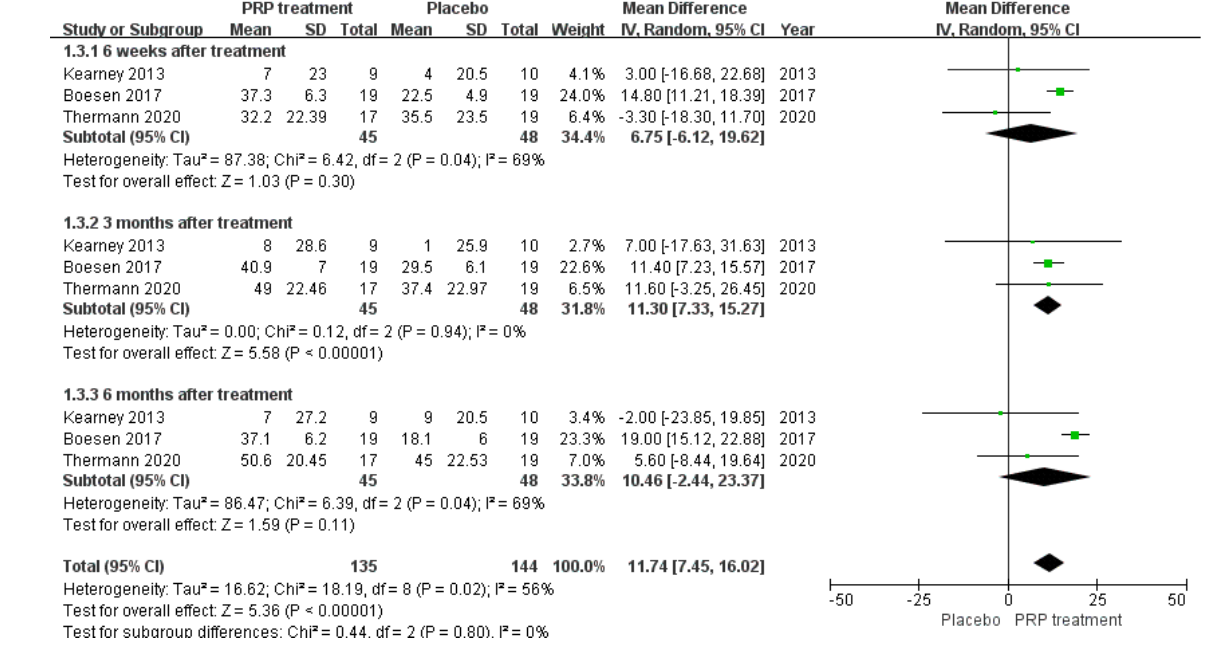
Figure 7. Forest plot of the change in visual analogue score.